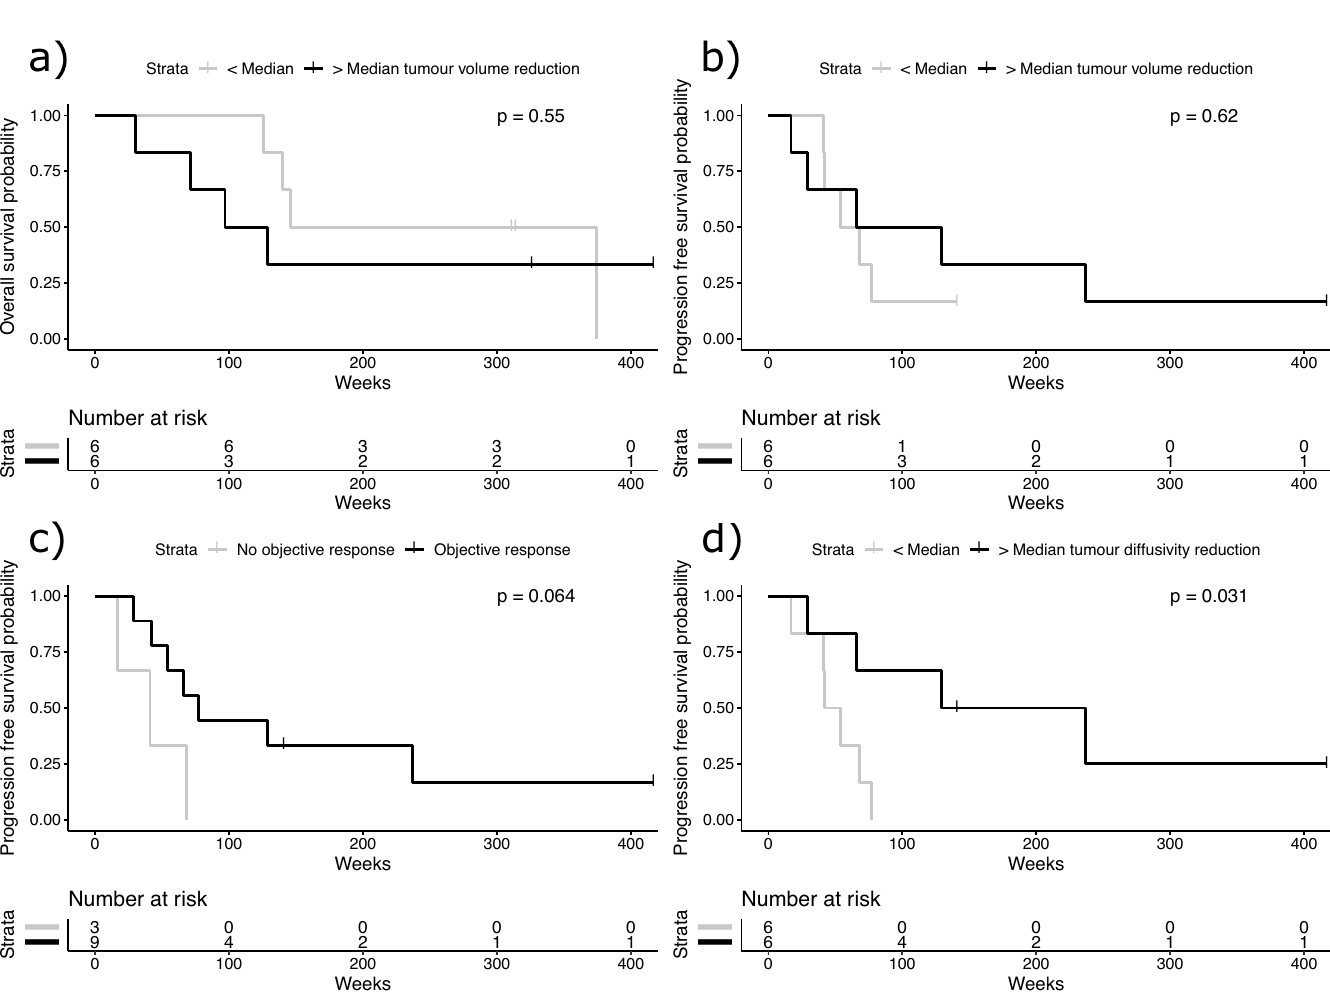
PLOS ONE | https://doi.org/10.1371/journal.pone.0258988 October 26,